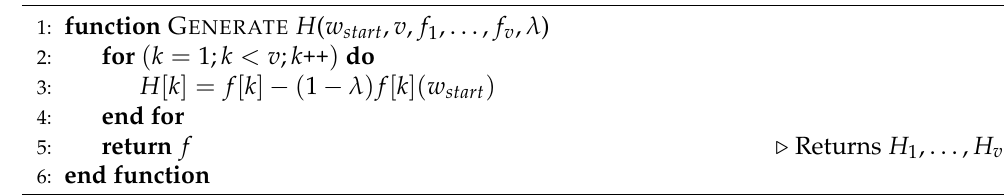
Algorithm 5 Generate the homotopy